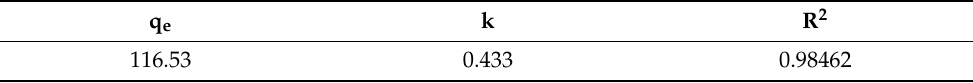
Table 1. Kinetic parameters for the pseudo-second-order models for the adsorption.